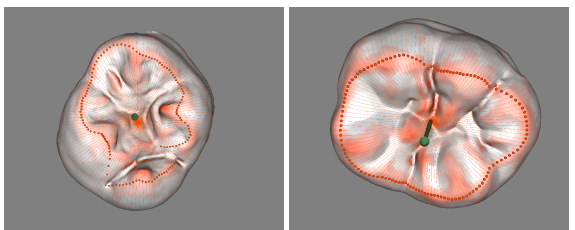
Figure 7. Linear parameters measured on contours of teeth for further calculations